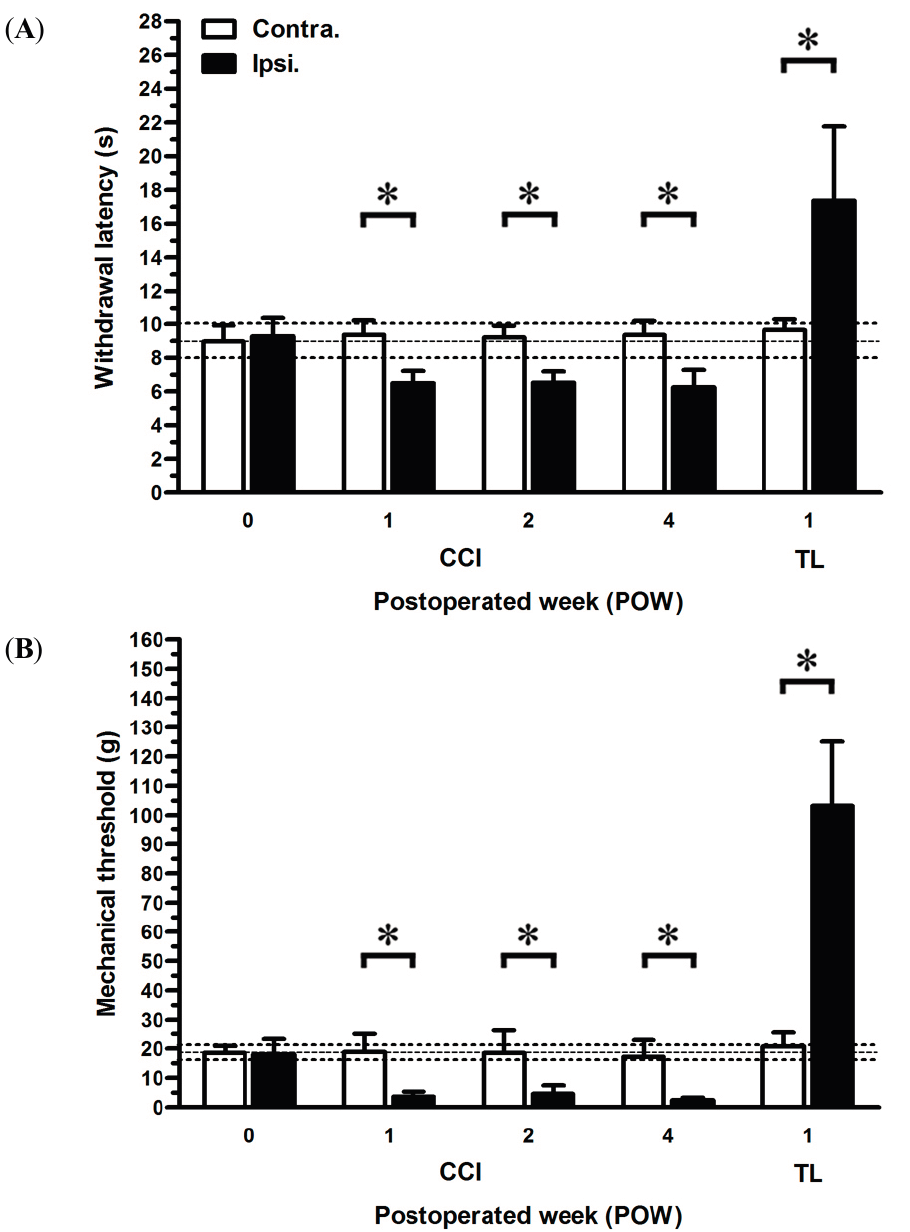
Figure 1. Effects of nerve compression injury on the temporal changes of neuropathic pain behaviors. The sequential changes of painful behaviors were shown in ( A ) thermal hyperalgesia and ( B ) mechanical allodynia. The thermal threshold of noxious radial heat was defined as withdrawal latency (s) and the degree of mechanical allodynia was expressed as the mechanical threshold (g) to the innocuous Von Frey filaments. Behavioral assessments were expressed as the mean ± standard deviation (SD) ( n = 5 at each time points after chronic constriction injury (CCI), n = 5 at post-operated week (POW) 1 after tight ligation (TL)). Each bar of values depicted in the contralateral sides (Contra., open bars) and ipsilateral sides (Ipsi., filled bars). Student’s t test was applied to examine the differences between the contralateral and ipsilateral sides at the same time points. Two-way repeated measures ANOVA was also performed following Bonferroni’s post-hoc test. * p < 0.05, indicated as a significant